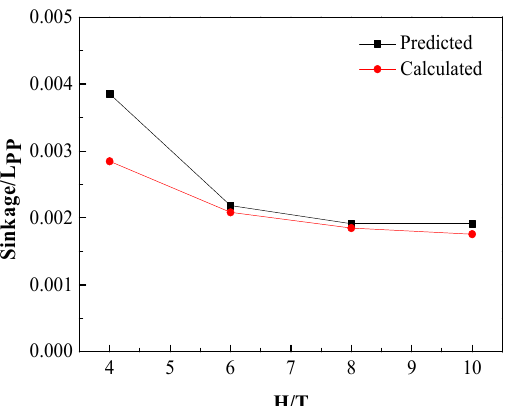
Figure 17. The comparison of model-scale dimensionless sinkage between the predicted value obtained by Raven’s formula ( Black ) and the calculated value obtained by CFD simulations ( Red ).